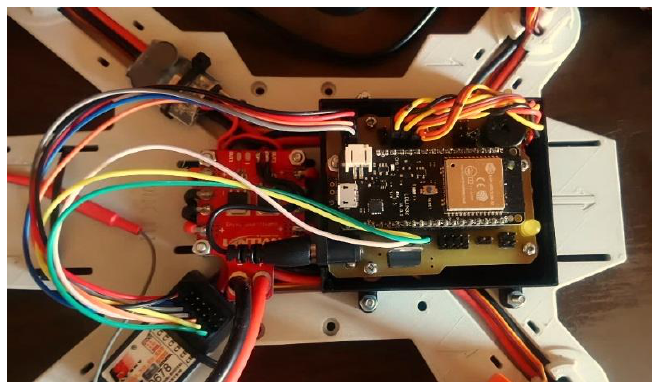
Figure 5. The prototype flight controller mounted on board [5].